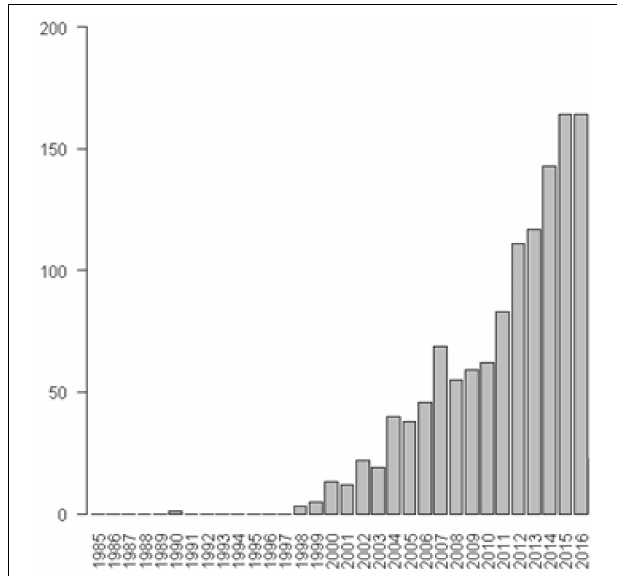
FIGURE 1 | Prevalence of the term ‘emotional intelligence’ in journal articles hosted in the PubMed database between 1985 and